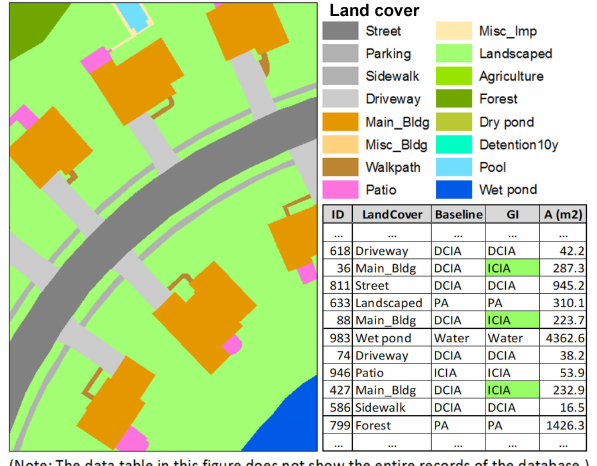
Figure 2. Sample GIS classified representation of the land cover and hydrologic characteristics.